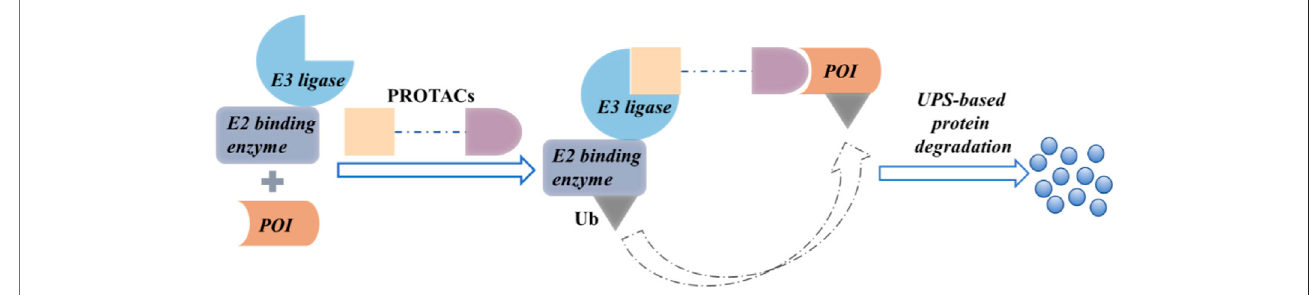
FIGURE 1 | The proposed mechanism of action of